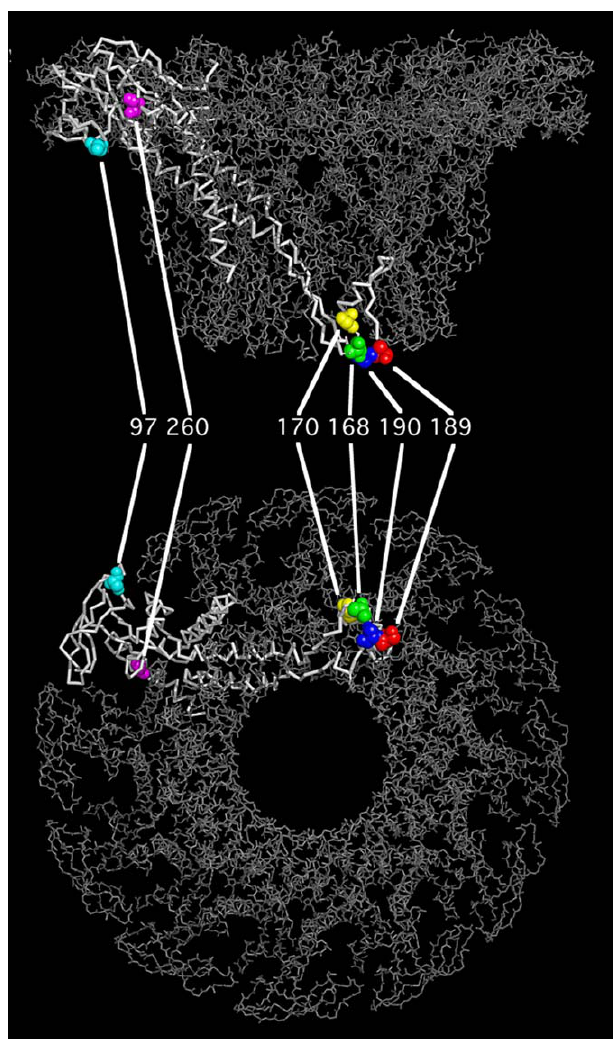
Figure 2. Connector Structure with Position of Dye Labels A schematic of the structure of the connector, based on the crystal structure by Simpson et al. [5] is shown. The positions of the residues that were mutated to cysteines and investigated with single-molecule fluorescence are